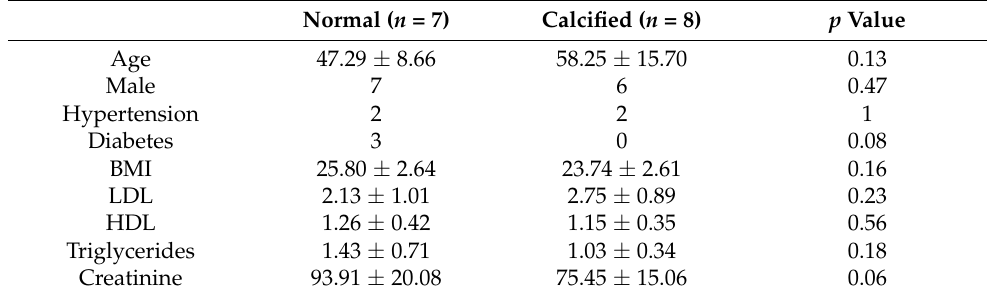
Table 1. Clinical characteristics of selected